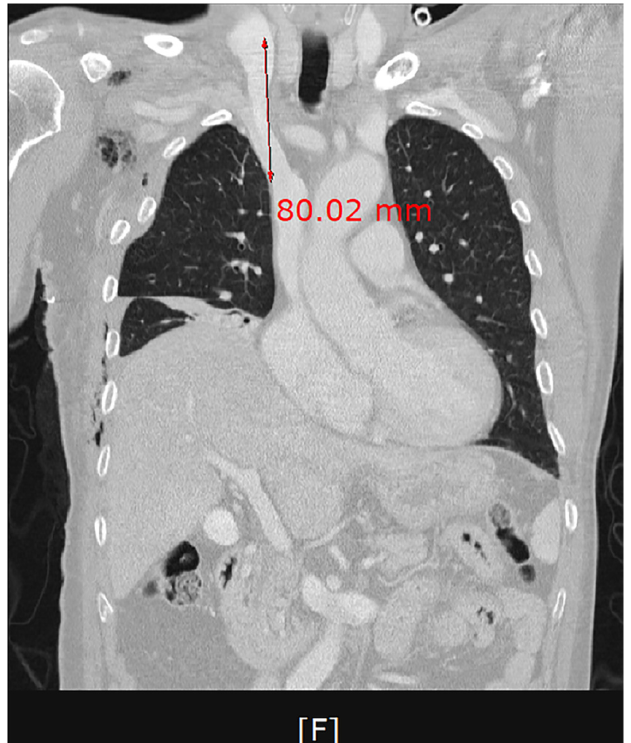
Figure 3. A frontal computed tomography scan of the chest. Approximately 80% of the length of a dilator corresponding to the distance between the site of puncture on the internal jugular vein and that on the superior vena cava.